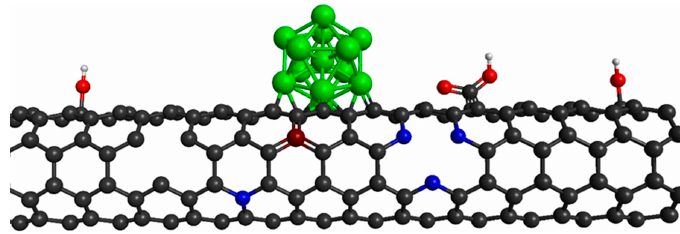
Figure 1. Surface functionalization and defect engineering in CNTs.